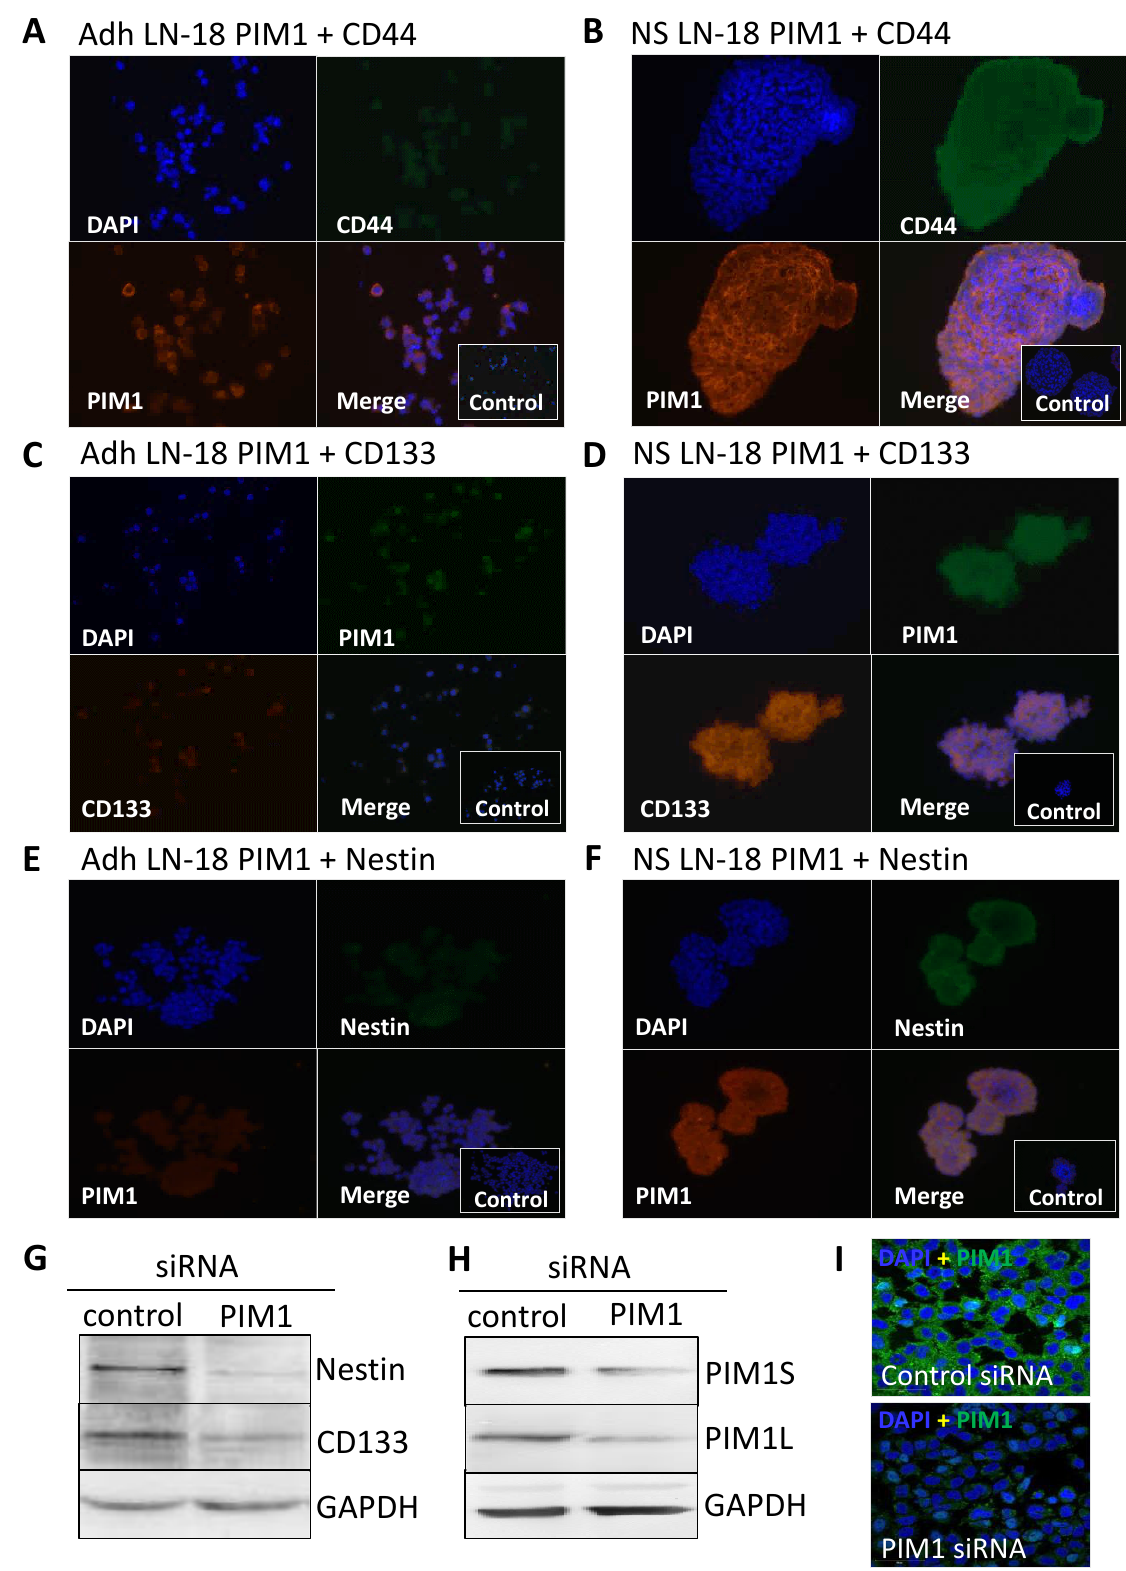
Figure 3. Co-Expression of PIM1 and stem cell markers in GBM neurospheres and after siRNA-mediated knockdown of PIM1. ( A – F ) Dual immunofluorescence staining of PIM1 (Alexa Fluor ® 568) with either CD44 ( A , B ) or with Nestin ( E , F )